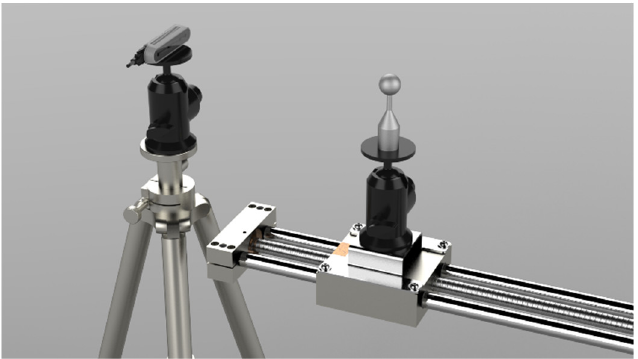
Figure 7. The acquisition setup for the very-close range evaluation test: the camera is mounted on a tripod facing the linear guide on which the sphere moves.